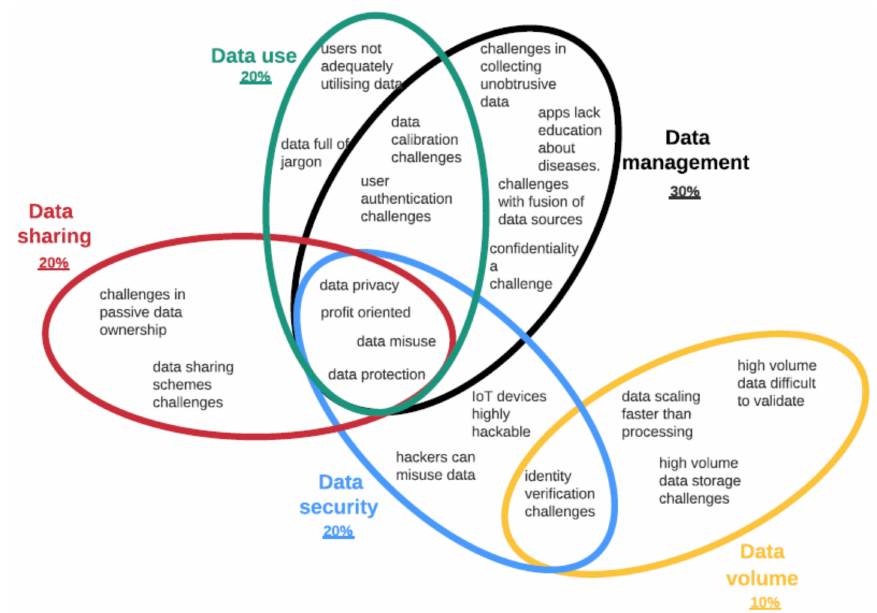
Figure 7. Highlighting healthcare data challenges in smart